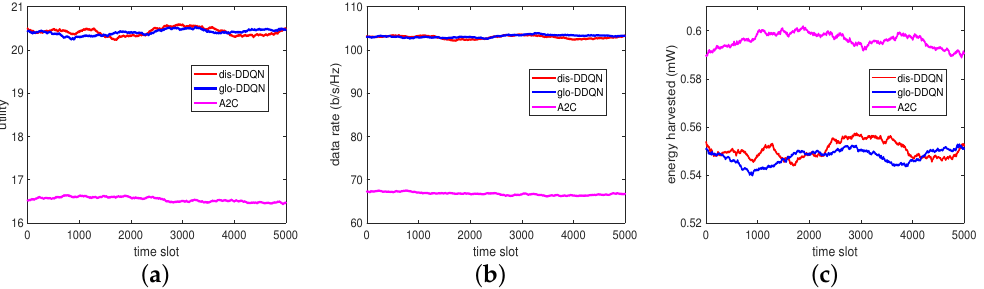
Figure 10. Test results of the RL-based algorithms: ( a ) utility, ( b ) data rate, and ( c ) harvested